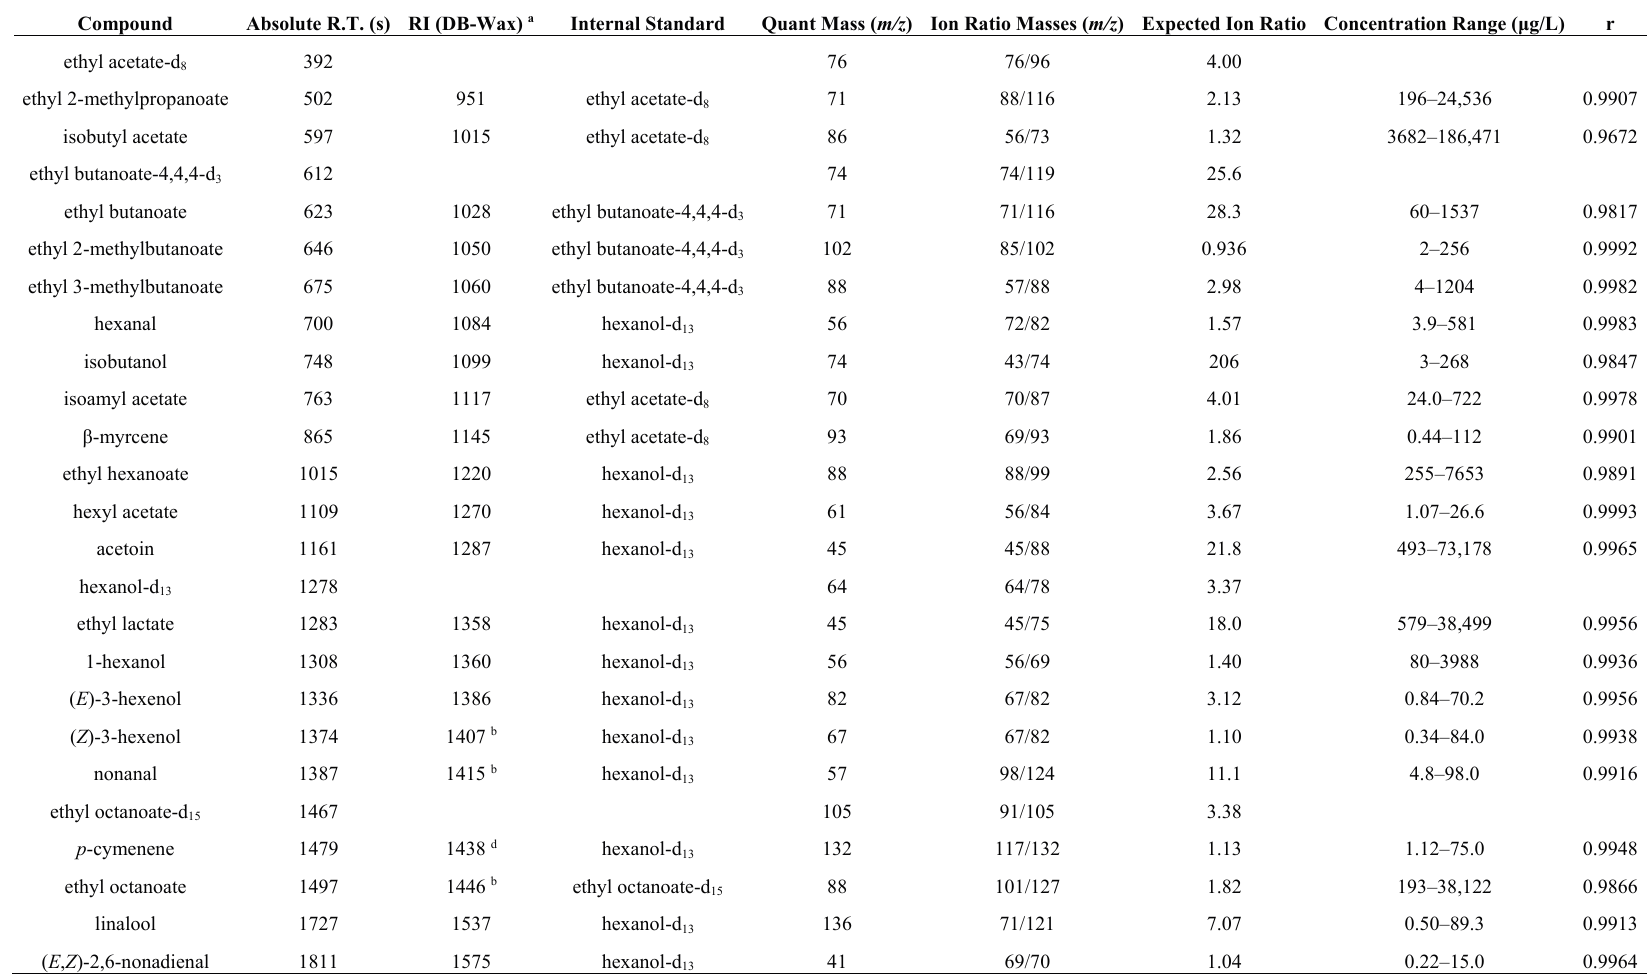
Table 7. Calibration parameters [retention times (RT), retention indices (RI), internal standards, quantitation masses ( m/z ), ion ratio masses, expected ion ratios ( m/z ), concentration ranges ( μ g/L, unless otherwise noted), and linear regression coefficients (r)] for the analysis of volatile compounds in wine using